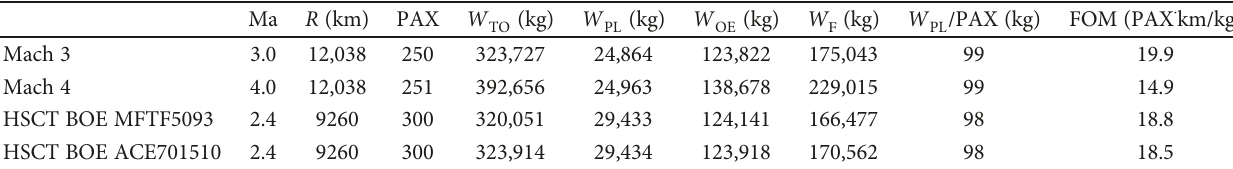
Table 2: Values of relevant parameters for calculating W R nc R